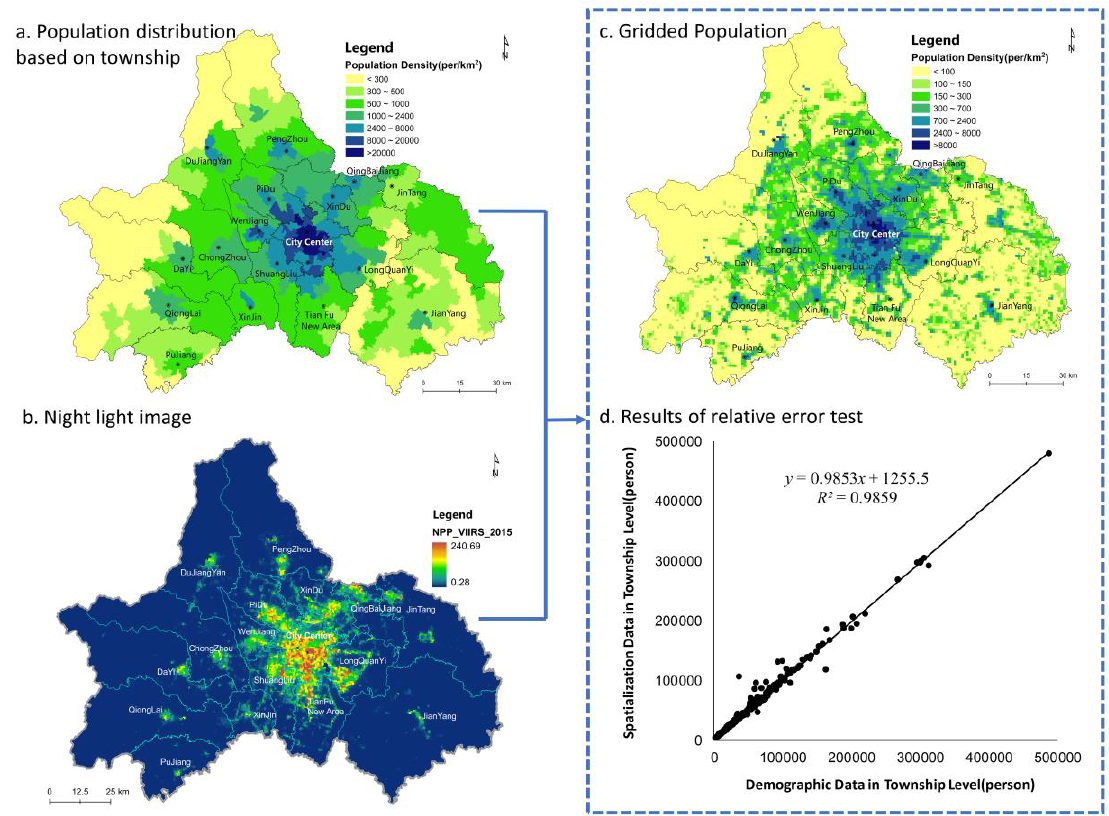
Figure 4. Processing of population gridding.